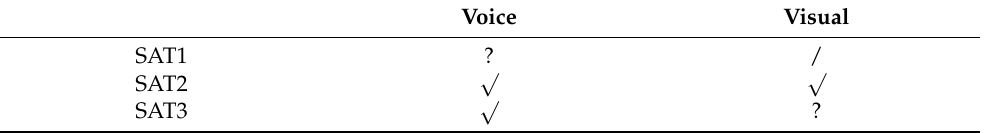
Table 1. Transparency design assumptions in proactive interaction condition of the in-vehicle